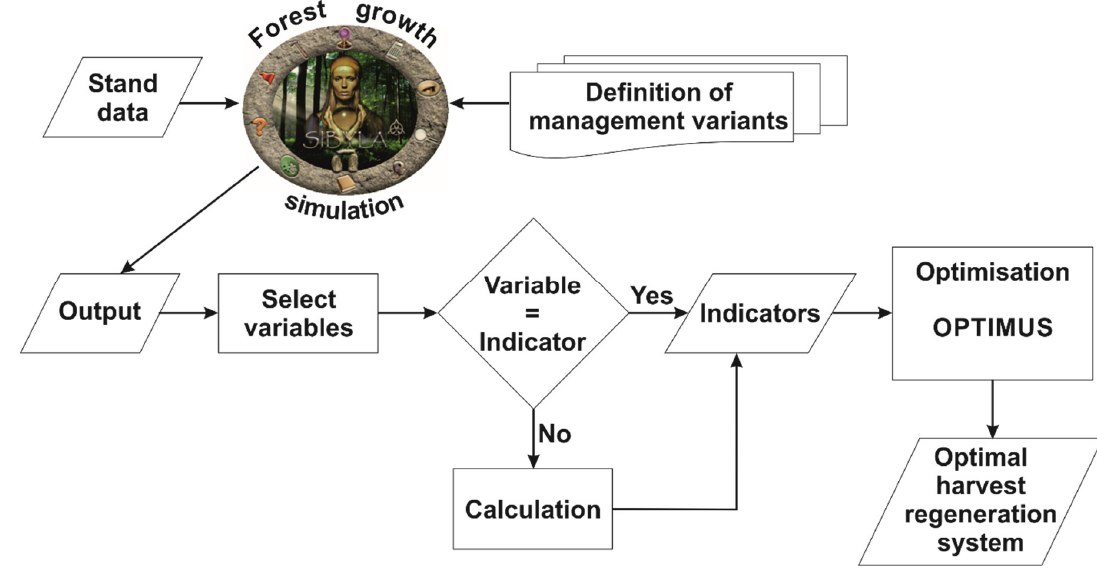
Figure 3. A scheme of the developed decision analysis tool.